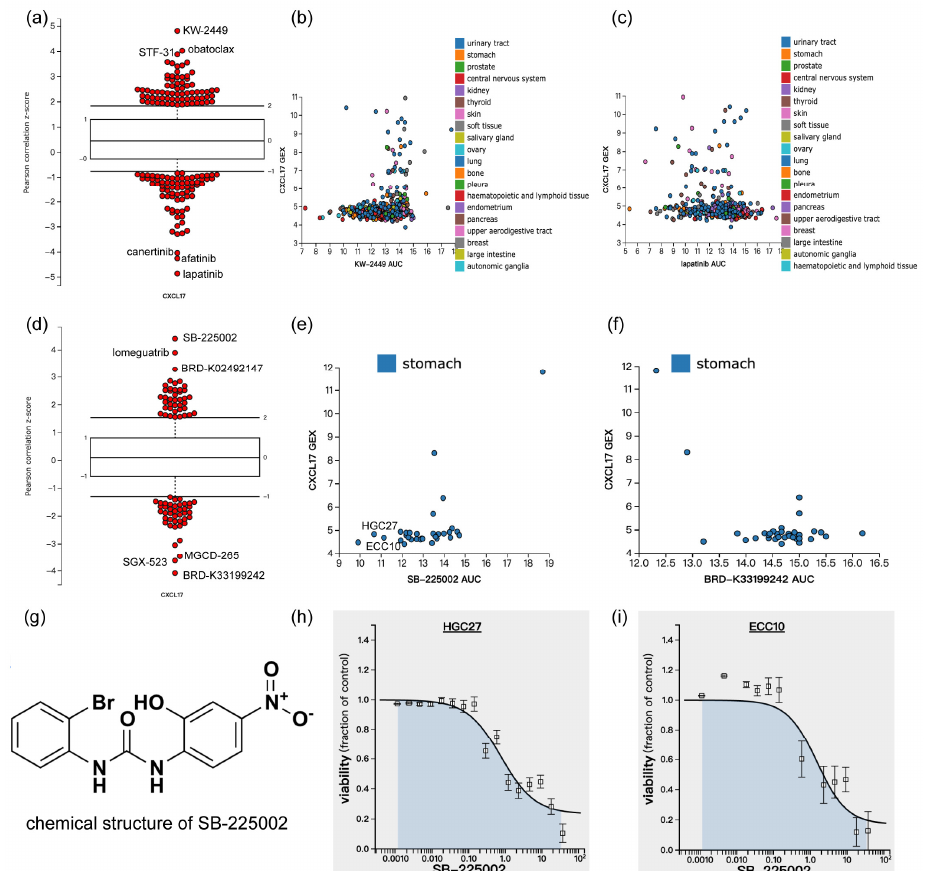
Figure 8. CXCL17 expression in different cancer cells with drug sensitivity identified by the CTRP database. An overview of CXCL17 expression levels with drug sensitivity regardless of cell origin ( a ). Overall, cancer cells with higher CXCL17 expression had a larger AUC of KW2449 ( b ) and a smaller AUC of lapatinib ( c ). An overview of CXCL17 expression levels with drug sensitivity in GC cell lines ( d ). GC cell lines with higher CXCL17 expression had a larger AUC of SB-225002 ( e ) and a smaller AUC of BRD-K33199242 ( f ). The structure of SB-225002 is shown ( g ), and as seen in ( h ) and ( i ), SB-225002 inhibited the cell viability of HGC27 and ECC10 cell lines in a dose-dependent manner. CTRP, Cancer Therapeutics Response Portal; AUC, area under the dose response curve.